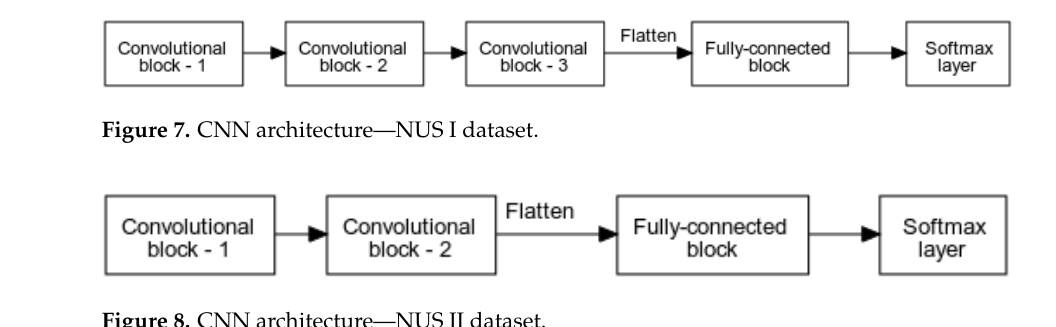
Figure 8. CNN architecture—NUS II dataset.